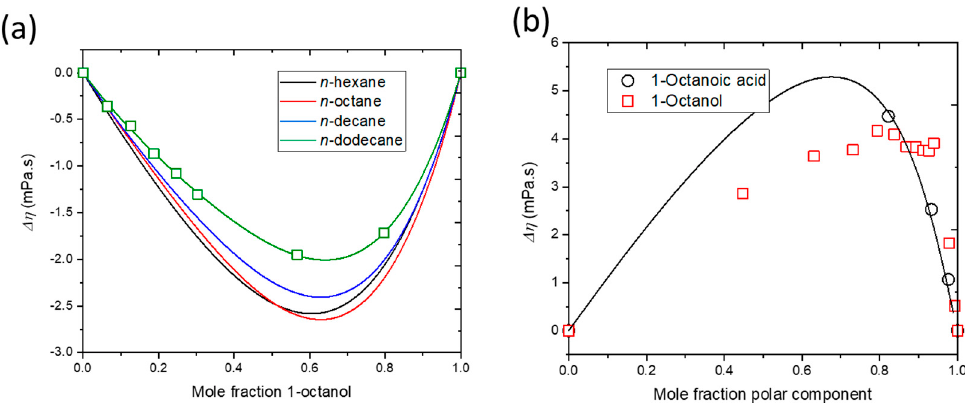
Figure 4. Excess viscosity plots for binary mixtures as a function of the mole fraction of the polar component, x 1 . ( a ) 1-Octanol mixtures with different n -alkanes: curves for n -hexane, n -octane, and n -decane are based on data from Ref. [12], and data for n -dodecane are from the present study. The drawn curves are Redlich–Kister polynomial fits (Equation (6)). ( b ) SO mixtures with octanol and octanoic acid. The curve for the SO / octanoic acid mixtures is the Redlich–Kister polynomial fit to data from Figure 3a, as a guide to predicted behavior in the absence of phase separation.